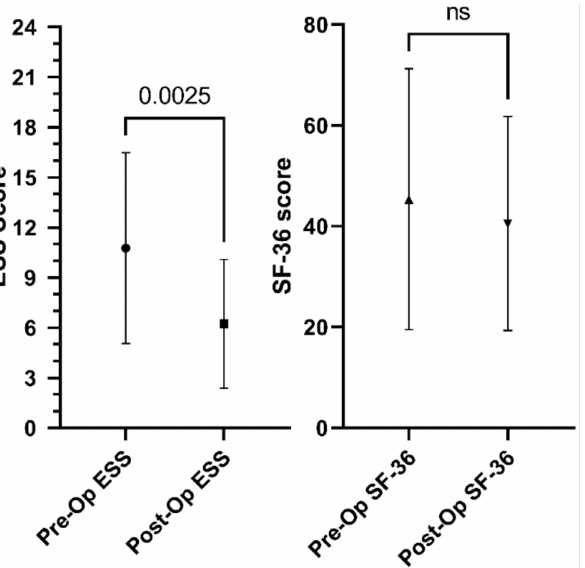
Figure 2. Pre- and post-operative comparison of the Epworth Sleepiness Scale and the SF-36 overall score. The exact p -value is shown above the